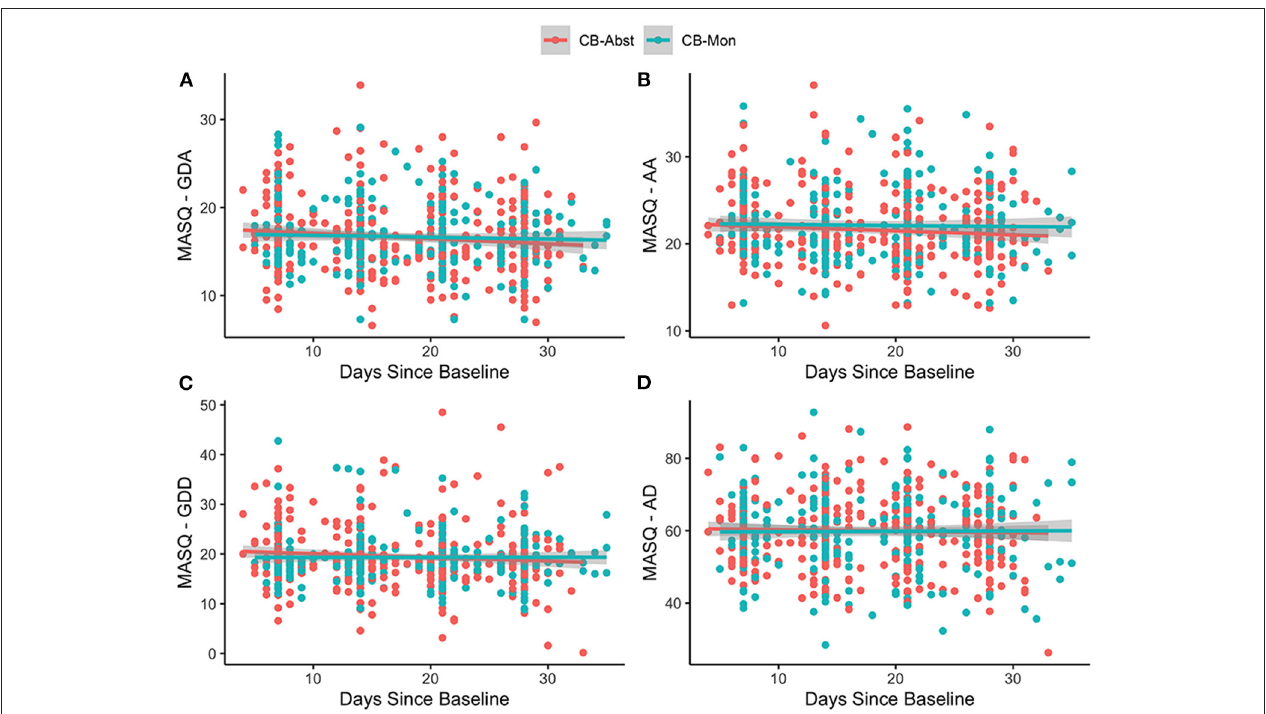
FIGURE 2 | MASQ scores by group over time. Figures show the individual observations of each MASQ subscale which have been adjusted for age, sex and baseline MASQ subscale as well as predictive slopes across time by randomization group; CB-Abst in coral and CB-Mon in teal. Supplementary Figure 1 displays the mean group differences with confidence intervals between CB-Abst and CB-Mon by visit. (A) age: stnd beta = − 0.03, p = 0.58, sex: stnd beta = 0.01, p = 0.96, ethnicity: stnd beta = 0.08, p = 0.57, baseline CN-THCCOOH: stnd beta = − 0.01, p = 0.81, baseline MASQ-GDA: stnd beta = 0.65, p < 0.001, time: stnd beta = − 0.11, p = 0.003, group: stnd beta = − 0.02, p = 0.86, time by group interaction: stnd beta = 0.08, p = 0.18. (B) age: stnd beta = − 0.04, p = 0.41, sex: stnd beta = 0.002, p = 0.98, ethnicity: stnd beta = 0.07, p = 0.64, baseline CN-THCCOOH: stnd beta = − 0.006, p = 0.91, baseline MASQ-AA: stnd beta = 0.72, p < 0.001, time: stnd beta = − 0.08, p = 0.01, group: stnd beta = 0.07, p = 0.51, time by group interaction: stnd beta = 0.07, p = 0.20. (C) age: stnd beta = − 0.01, p = 0.84, sex: stnd beta = 0.11, p = 0.27, ethnicity: stnd beta = 0.04, p = 0.75, baseline CN-THCCOOH: stnd beta = 0.01, p = 0.84, baseline MASQ-GDD: stnd beta = 0.66, p < 0.001, time: stnd beta = − 0.08, p = 0.02, group: stnd beta = − 0.07, p = 0.46, time by group interaction: stnd beta = 0.08, p = 0.12. (D) age: stnd beta = − 0.05, p = 0.36, sex: stnd beta = − 0.03 p = 0.73, ethnicity: stnd beta = 0.13, p = 0.32, baseline CN-THCCOOH: stnd beta = 0.01, p = 0.84, baseline MASQ-AD: stnd beta = 0.69, p < 0.001, time: stnd beta = − 0.03, p = 0.34, group: stnd beta = − 0.04, p = 0.72, time by group interaction: stnd beta = 0.03, p =